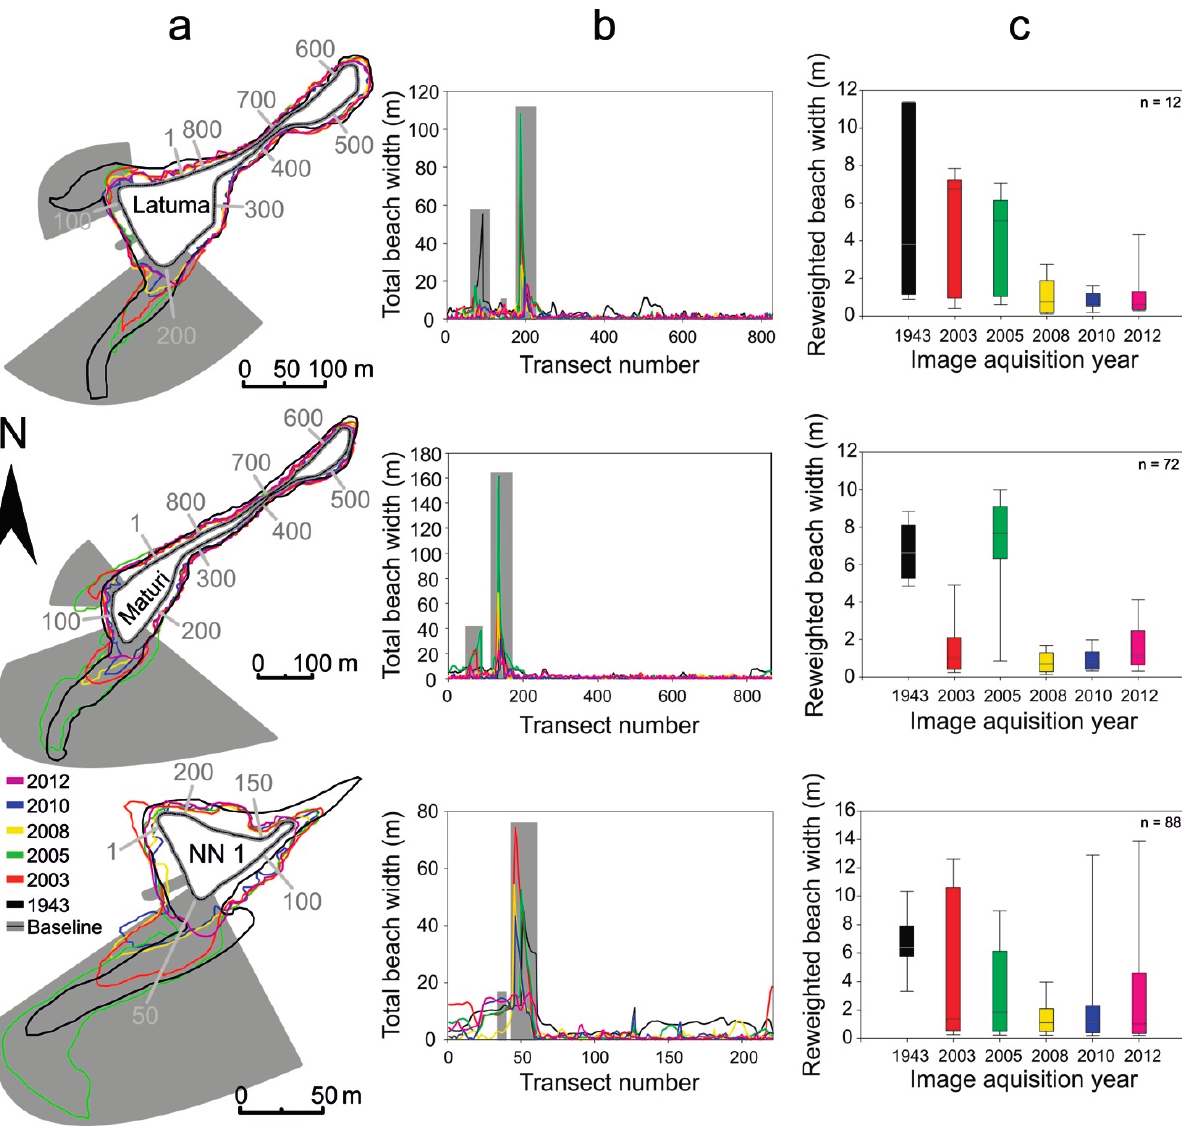
Figure 10. ( a ) Illustration of superposed toe of beach positions for Latuma, Maturi and NN 1. Selected transects are marked in light grey to indicate their position on the map ( b ) Changes in total beach width as a function of Shoreline Change Envelope. Dark grey backgrounds in a and b display the range of transects that comprised extreme high SCE values. ( c ) Box plots showing the 10th, 25th, 50th, 75th and 90th percentiles of reweighted beach width. n = number of